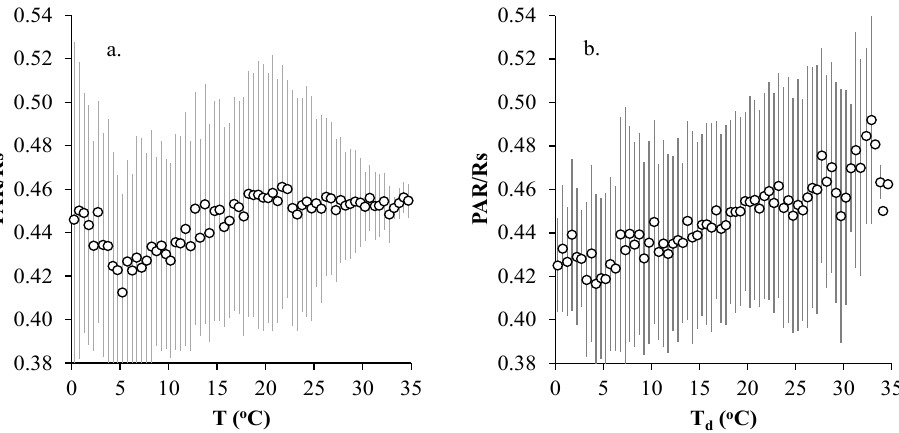
Figure 8. Averages and standard deviations of the PAR/Rs hourly ratio with the variation of ( a ) the air temperature T and ( b ) dewpoint temperature T d , grouped in 0.1 bin-classes.